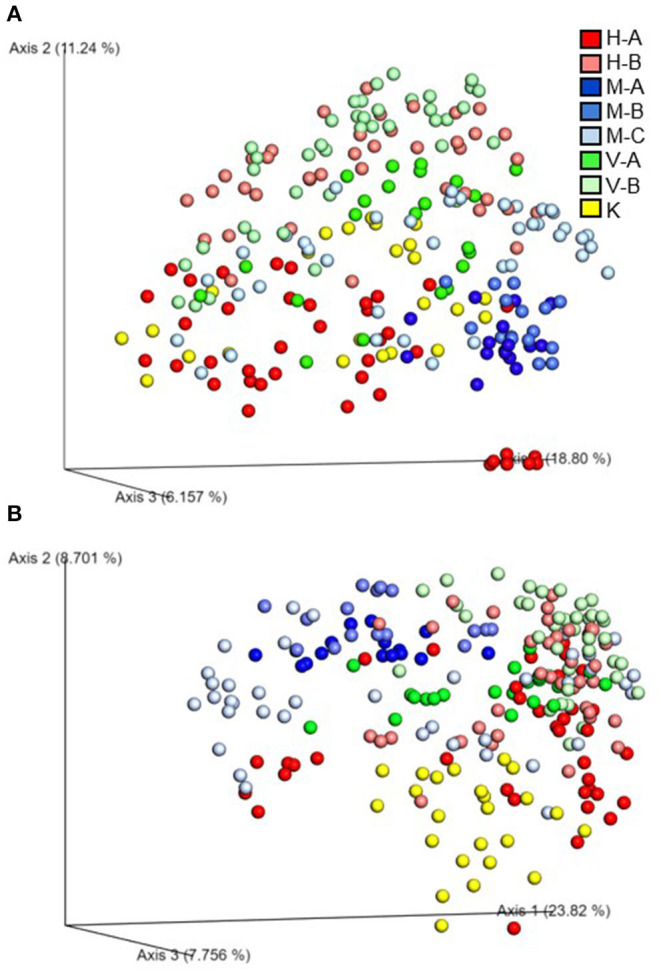
Emperor plot showing beta diversity distances among the different samples from the four farms in Northwest Arknasas as measured by (A) unweighted UniFrac distance and (B) Bray-Curtis distance indices. A, B, and C represent different flocks.